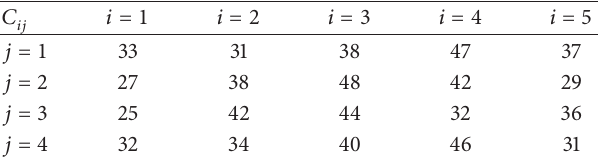
Table 6: The generalized transportation costs (unit: Yuan).